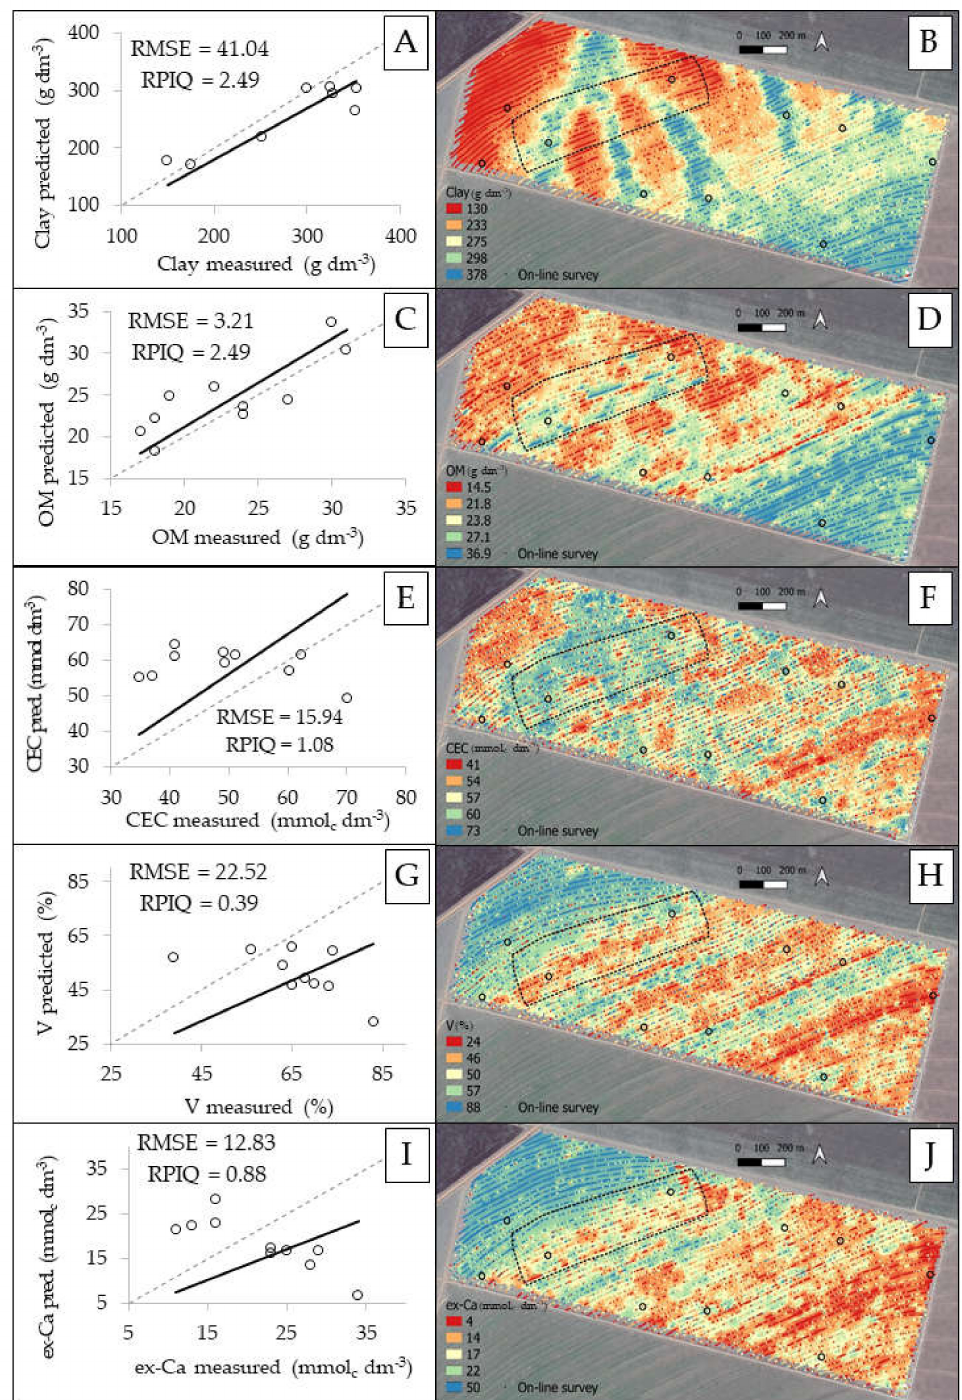
Figure 5. Scatter plots (for the 10 verification points) of measured versus predicted fertility attributes that presented satisfactory performance (in the calibration area) while using artificial neural network (ANN) models ( A , C , E , G , I ); the prediction results of this independent testing are detailed in Table A1 (Appendix A). Fertility attribute maps obtained after interpolation of the predictions using ANN models ( B , D , F , H , J ). The data were interpolated by kriging using the Vesper 1.63 software [42] and a 10 × 10 m grid, i.e., with a resolution compatible with that of the data acquisition. On the maps, the boundary of the calibration area is represented in black dashed lines and the position of the soil samples used in the independent testing in black